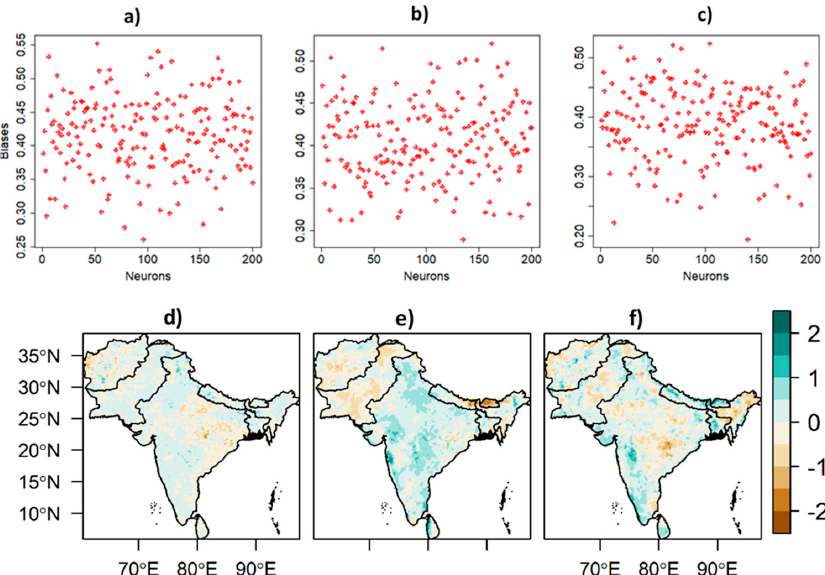
Figure 17. The bias of the DFNN model between simulated and observed SMDI: bias of each neurons during the training of the model at SOS ( a ), LOS ( b ), and EOS ( c ) stage; spatial distribution of bias at SOS ( d ), LOS ( e ), and EOS ( f ) stage in South Asia.